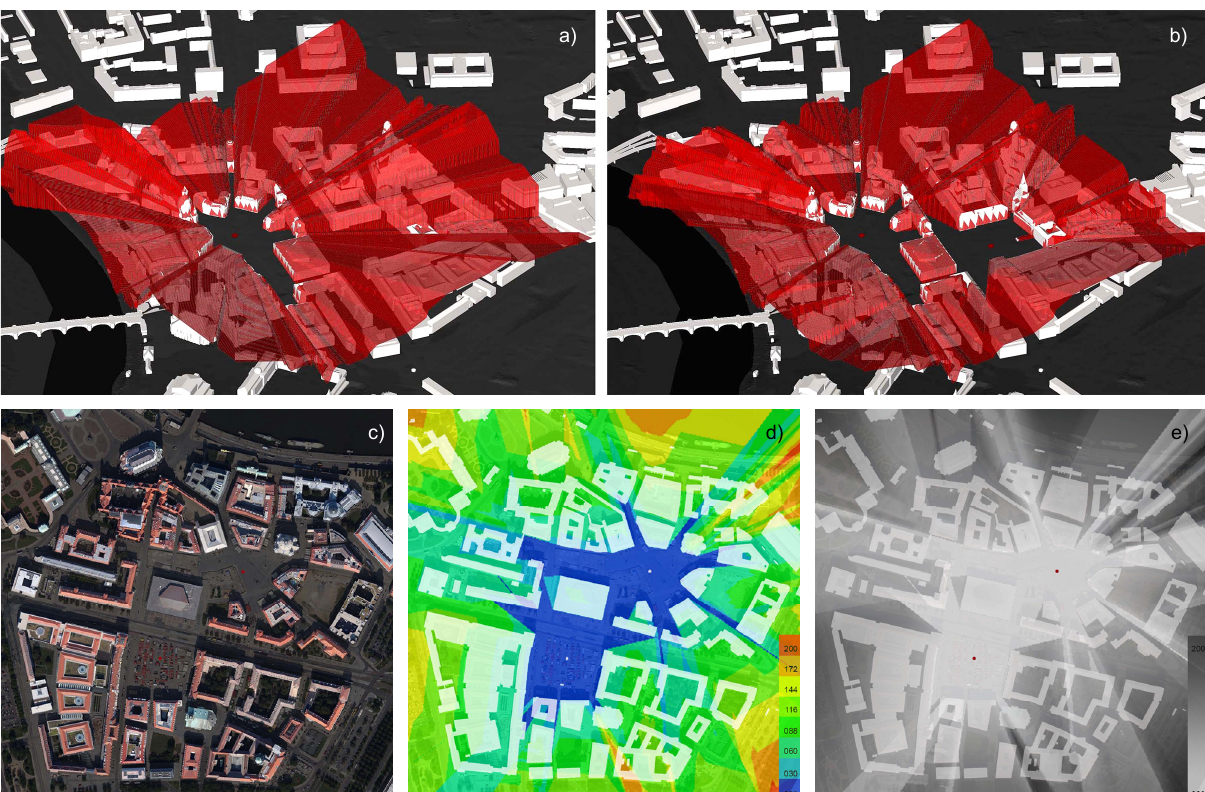
Figure 5. Calculating VPS surfaces for 2 squares in Dresden: a) VPS for single view point, b) VPS for two view points; c) ortophotomap of section of Dresden with points marked; d, e) VPS map defining height limits for new